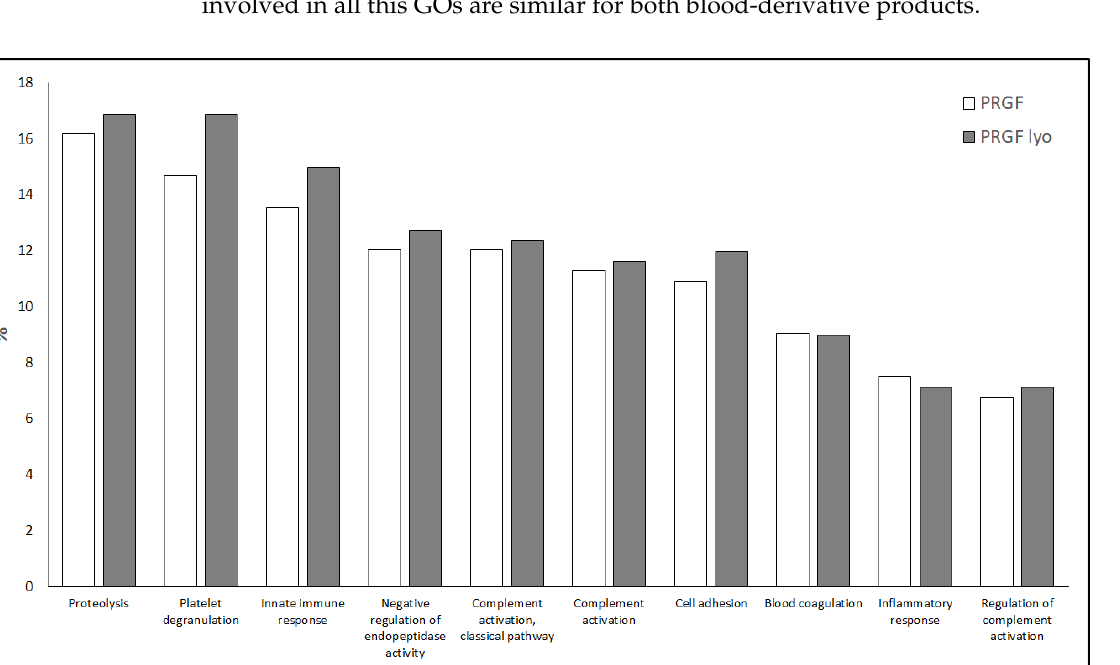
Figure 2. Venn diagram comparison of two blood – derived formulations and the list of proteins spe- cific for PRGF and PRGF lyo.